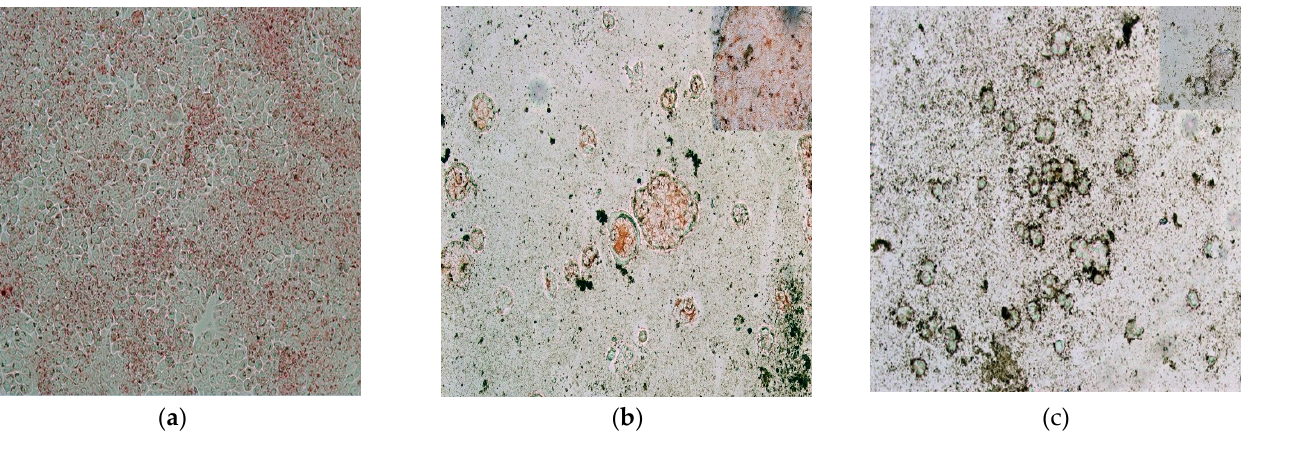
Figure 10. Red-stained HT-29 cells (mixed with 3 mg/mL of MNPs and after 24 h of incubation): ( a ) without MHT exposure; with MHT at ( b ) 43 °C, and ( c ) 48 °C.